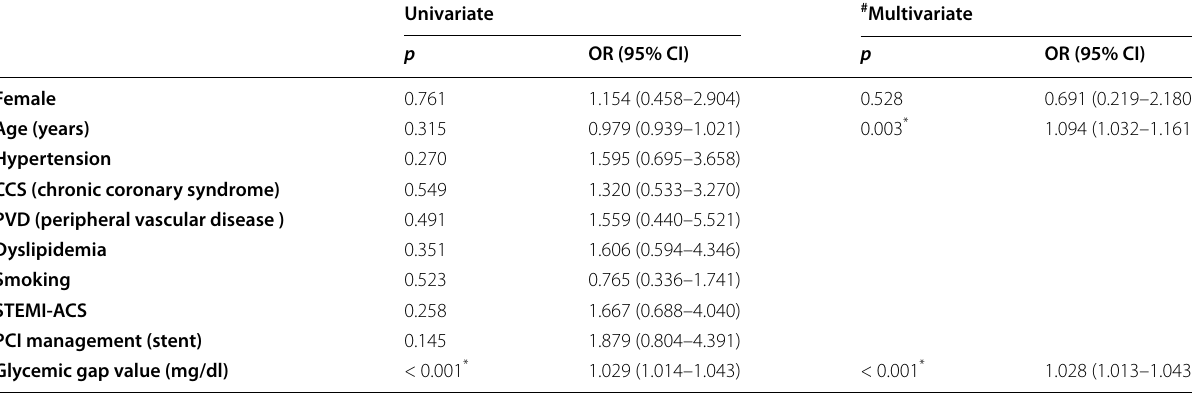
OR odd’s ratio, CI confidence interval # All variables with p < 0.05 was included in the multivariate *Statistically significant at p ≤